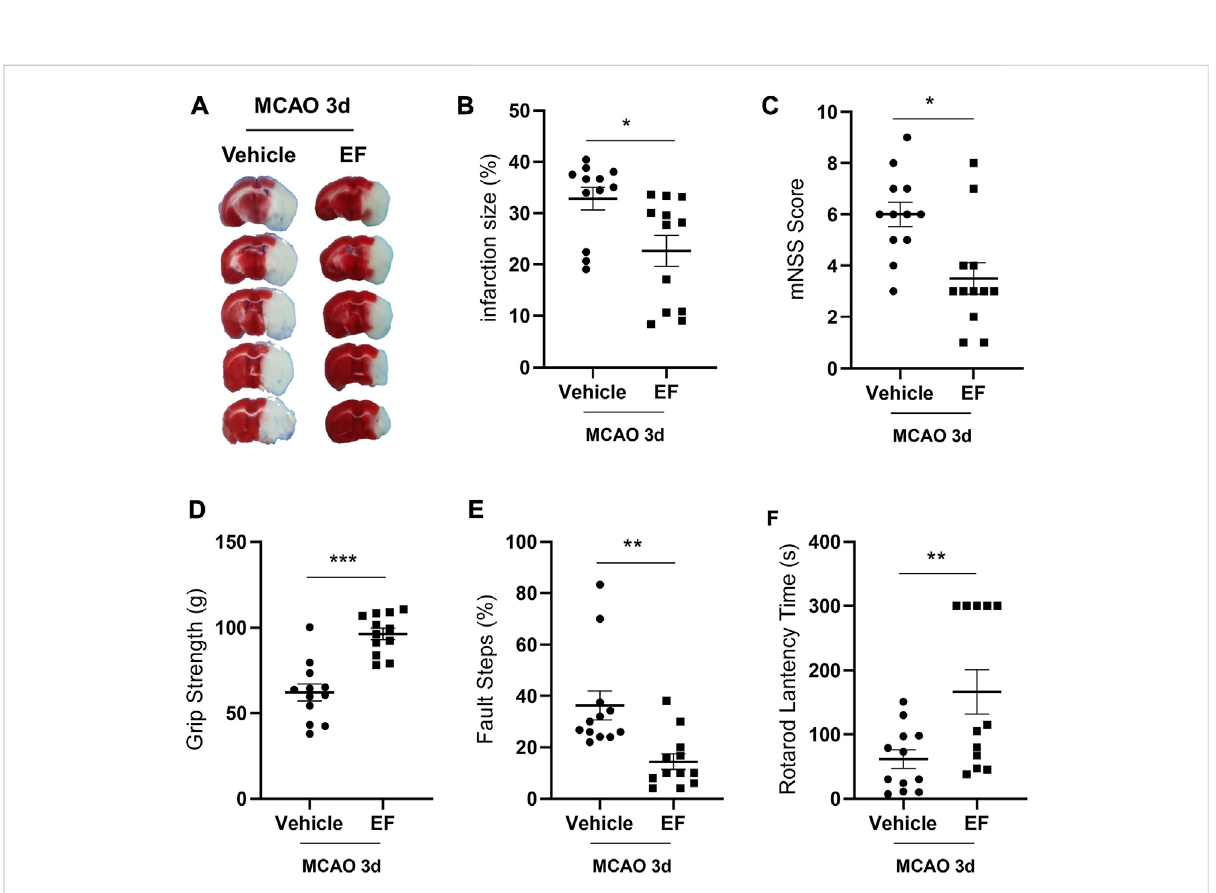
FIGURE 4 EFreducesinfarctsizeandamelioratesneurologicalde fi citsinexperimentalstroke.MicesubjectedtoMCAOwereadministeredwithvehicleor EF (15 mg/Kg, once a day for 3 days) via i.p. injection. (A) Representative images of brain sections stained with TTC at the third day after tMCAO. (B) Infarctionvolume. (C) ThemNSSscores. (D) Theresults ofgripstrength. (E) Theresultsoffaultsteps. (F) Theresults oftherotarodtest.Valuesshown are expressed as the mean ± SEM, n = 12/group. * p < 0.05, ** p < 0.005, *** p < 0.0001 compared with vehicle-treated MCAO